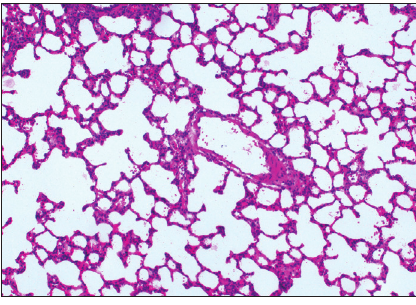
Figure 1. Appearance of normal lung (H&E, ×100).